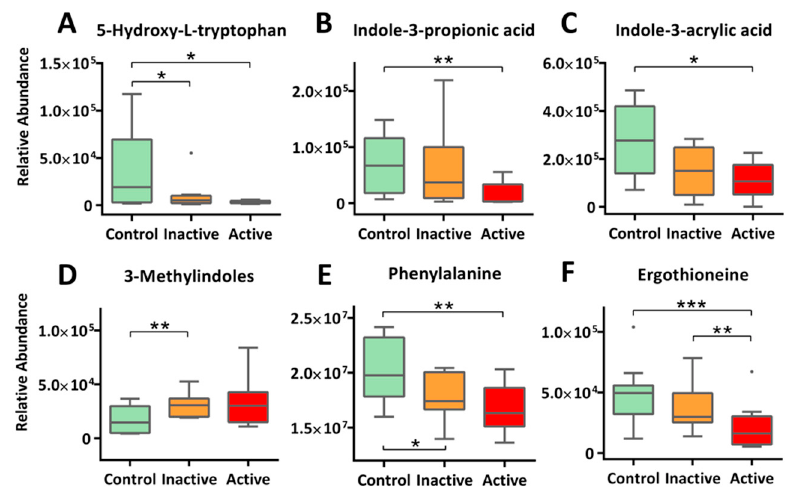
Figure 4. Altered metabolism of amino acids were extensively observed for Crohn’s patients. This includes diminishing 5-HTP, the immediate precursor of 5-HT ( A ), microbe-mediated tryptophan metabolism ( B – D ), phenylalanine metabolism ( E ), and histidine metabolism ( F ). The y -axis measures the peak height of the profiled metabolites, and the x -axis marks the three IBD groups for comparison, namely control (green), inactive (orange) and active (red), outliers, represented as dots, were excluded from comparison. *** p < 0.001, ** p < 0.01, * p < 0.05.